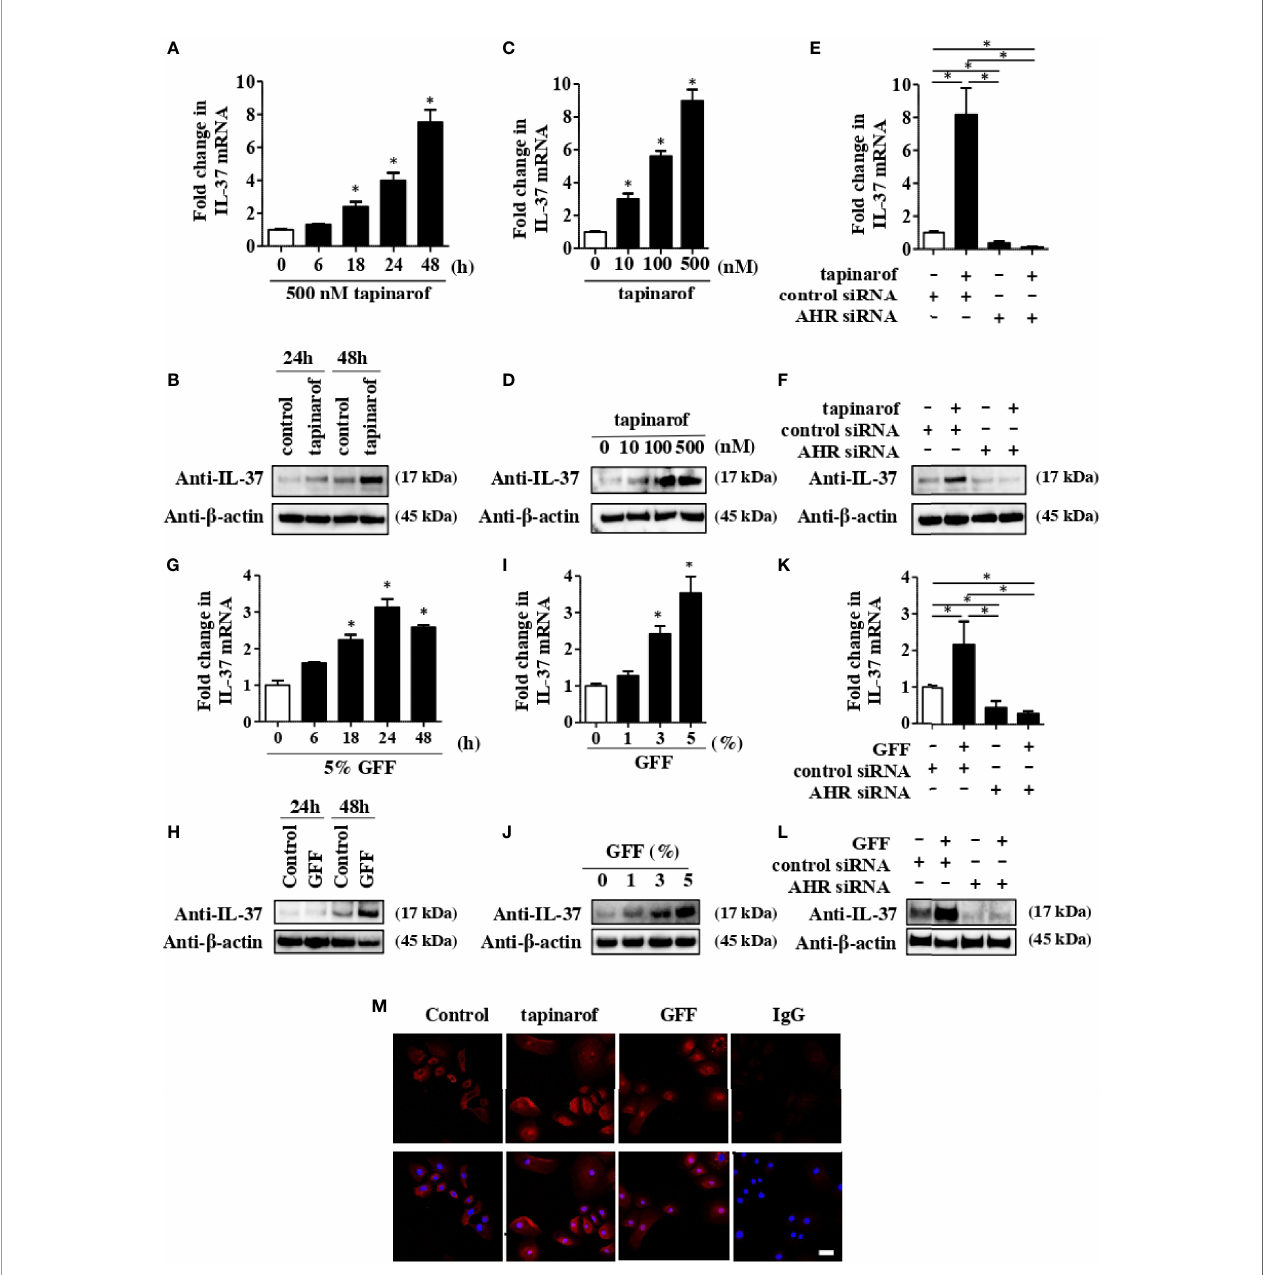
FIGURE 1 | Tapinarof and GFF treatment upregulated IL-37 via AHR in NHEKs. Normal human epidermal keratinocytes (NHEKs) were treated with either tapinarof (500 nM) (A, B) or GFF (G, H) for the indicated period. NHEKs were treated with either tapinarof (C, D) or GFF (I, J) at the indicated dose for 48 h (A, C, G, I) The level of IL-37 mRNA was analyzed by qRT-PCR. Data are expressed as mean ± S.E.M.; n = 3 for each group. Statistically signi fi cant differences in the expression of control and tapinarof- or GFF-treated NHEKs are presented: *p < 0.05. (B, D, H, J) Total cell lysates were prepared and subjected to western blotting analysis with an anti-IL-37 antibody. The data are representative of experiments repeated three times with similar results. (E, F, K, L) NHEKs were transfected with either control siRNA (control siRNA) or siRNA against AHR (AHR siRNA) and subsequently treated with either tapinarof (500 nM) or GFF (5%) for 48 h (E, K) The mRNA level of IL- 37 was analyzed by qRT-PCR. Data are expressed as mean ± S.E.M.; n = 3 for each group. Statistically signi fi cant differences between the expression of control and tapinarof- or GFF-treated NHEKs are presented: *p < 0.05. (F, L) The level of protein of IL-37 was analyzed by western blotting with an anti-IL-37 antibody. The data are representative of experiments repeated three times with similar results. (M) Immuno fl uorescent staining analysis using confocal laser scanning microscopy. NHEKs under control treatment or treated with tapinarof (500 nM) or GFF (5%) for 12 h were stained with an anti-IL-37 antibody (primary antibody) and an Alexa Fluor 546-conjugated anti-rabbit IgG antibody (red: secondary antibody). DAPI (4 ′ ,6-diamidino-2-phenylindole) was utilized for nuclear staining. IgG: isotype negative control: The scale bar represents 25 m m. The data are representative of experiments repeated three times with similar